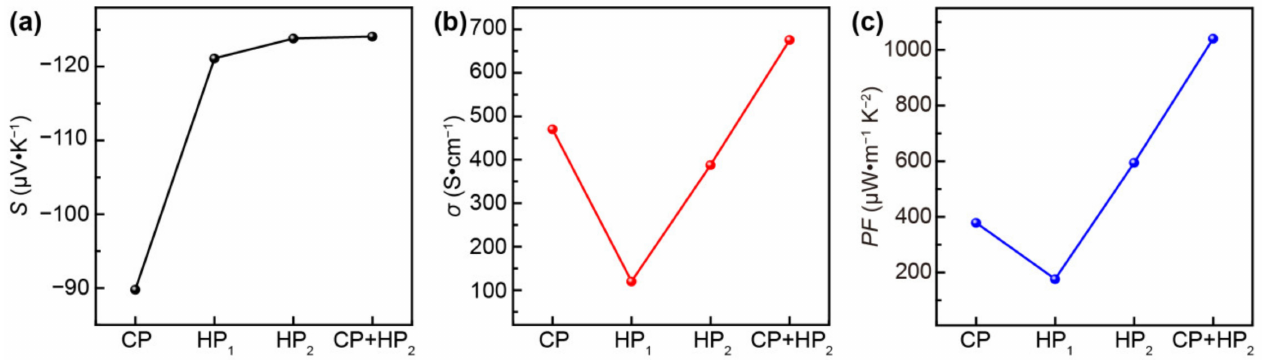
Figure 2. TE performance of Ag 2 Se/nylon film of sample 2 with different film processing methods. ( a ) Seebeck coefficient, ( b ) electrical conductivity, ( c ) power